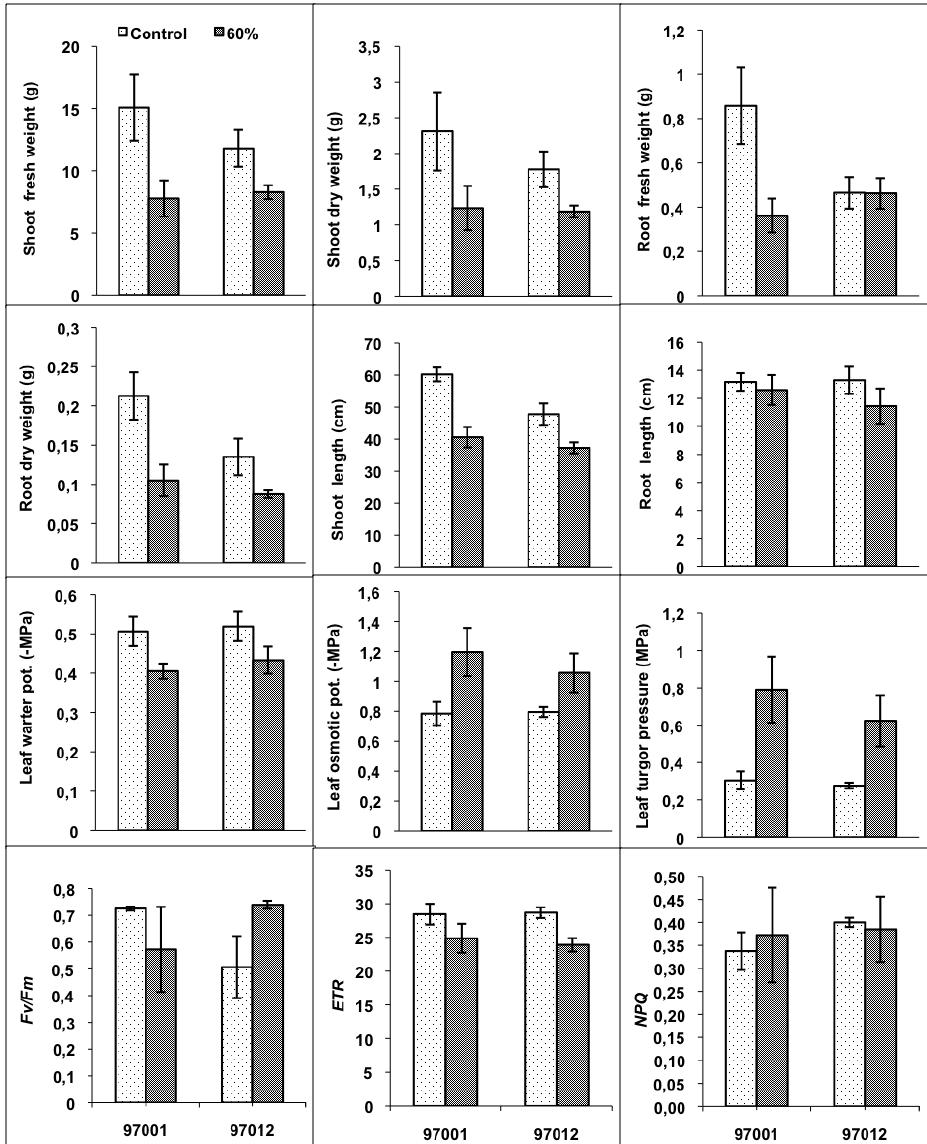
Fig. 1: Growth, water relations and chlorophyll fluorescence attributes of mungbean [ Vigna radiata (L.) Wilczek] when 30 day old plants were subjected to drought stress (Mean ± S.E.; n = 4).